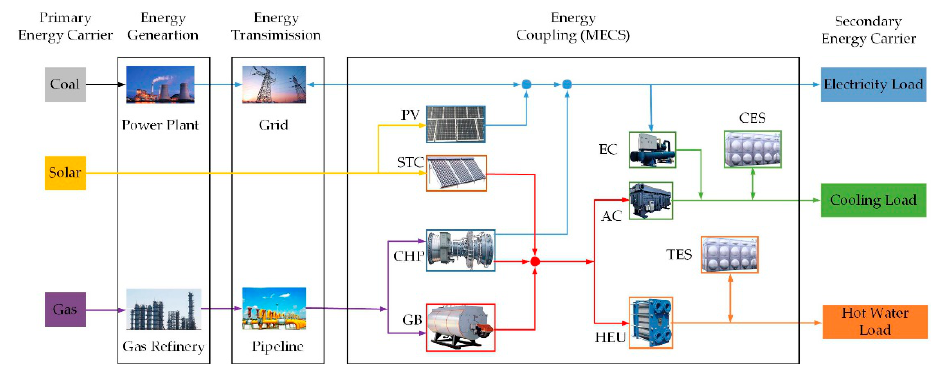
Figure 1. An MECS (multiple energy carrier system) coupled with diverse energy carriers.